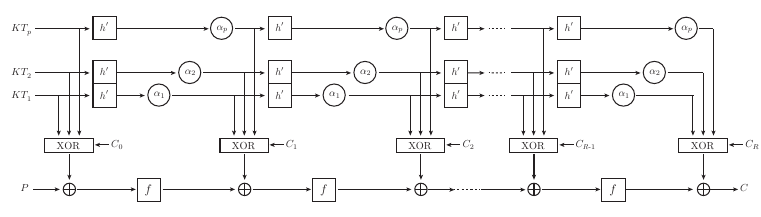
Figure 2: The Tweakey framework.